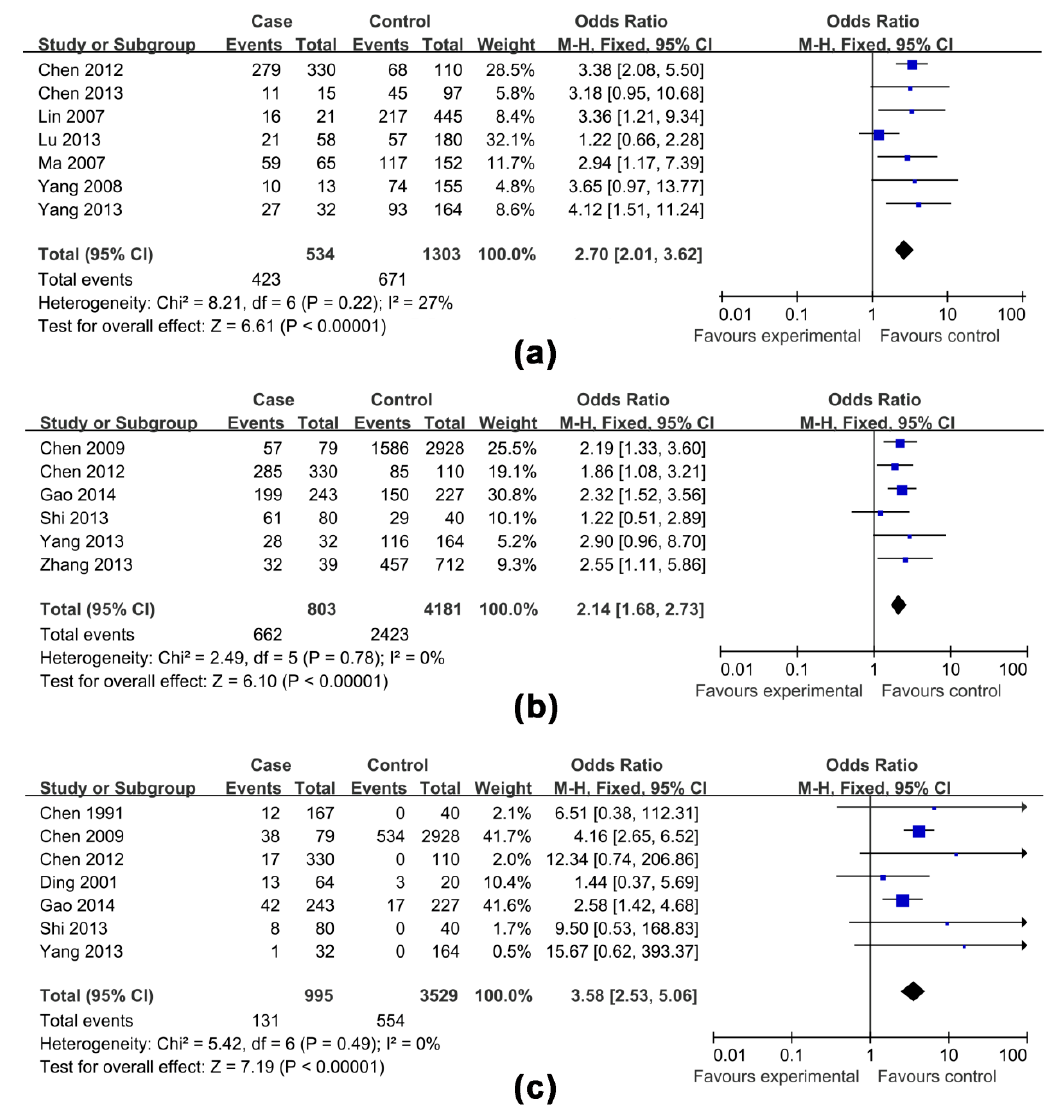
Figure 2. Effects of possible risk factors in chronic HBV-infected patients: ( a ) non-antiviral treatment; ( b ) male gender; and ( c ) a family history of HCC.